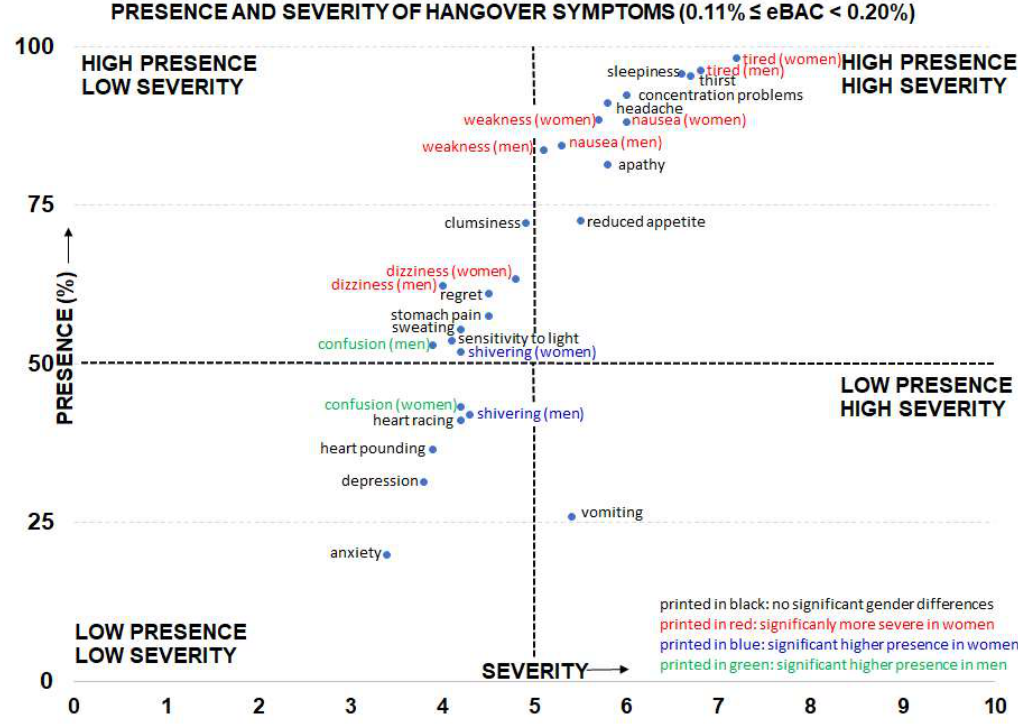
Figure 1. Presence and severity of individual hangover symptoms after alcohol consumption and reaching an eBAC of 0.11% ≤ eBAC < 0.2%. Sex di ff erences are significant if p < 0.002. Abbreviation: eBAC = estimated blood alcohol concentration.